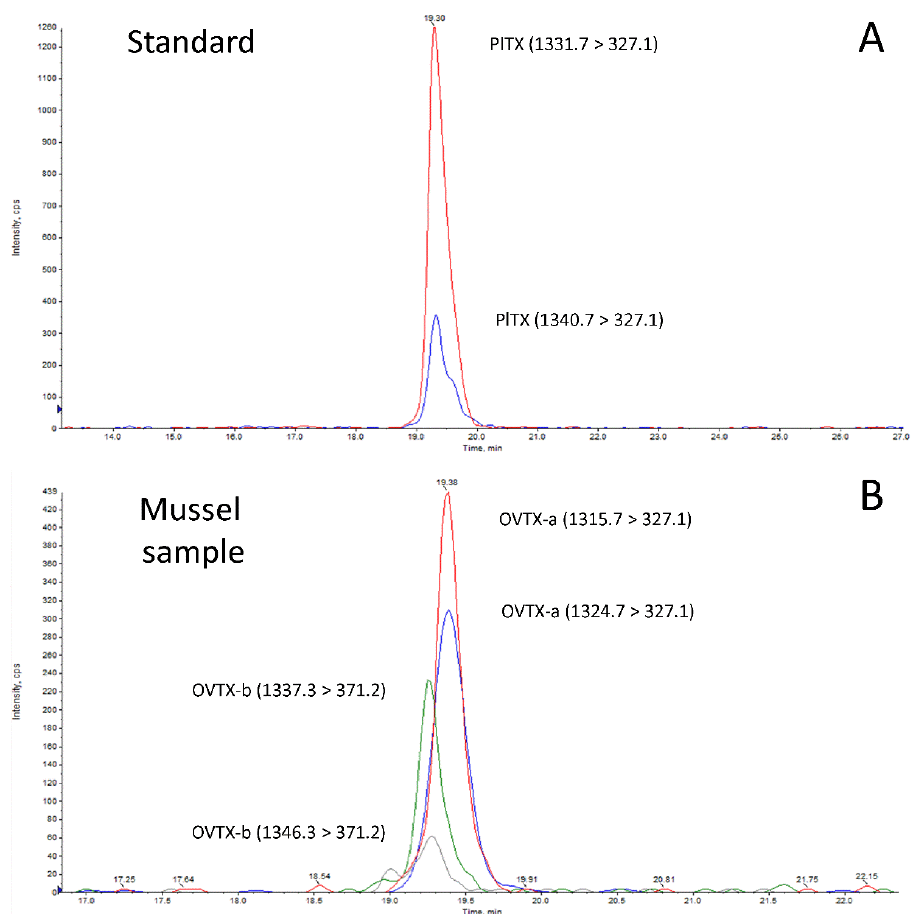
Figure 6. LC-MS/MS chromatograms of the ( A ) PlTX matrix-matched standard, ( B ) OVTX-a, and OVTX-b in the sample from Portonovo from 20 September. 1331.7 > 327.1, 1315.7 > 327.1, 1337.3 > 371.2 multiple reaction monitoring (MRM) transitions for PlTX, OVTX-a, and OVTX-b quantification, respectively. 1340.7 > 327.1, 1324.7 > 327.1, 1346.3 > 371.2, MRM transition for PlTX, OVTX-a, and OVTX-b confirmation, respectively.